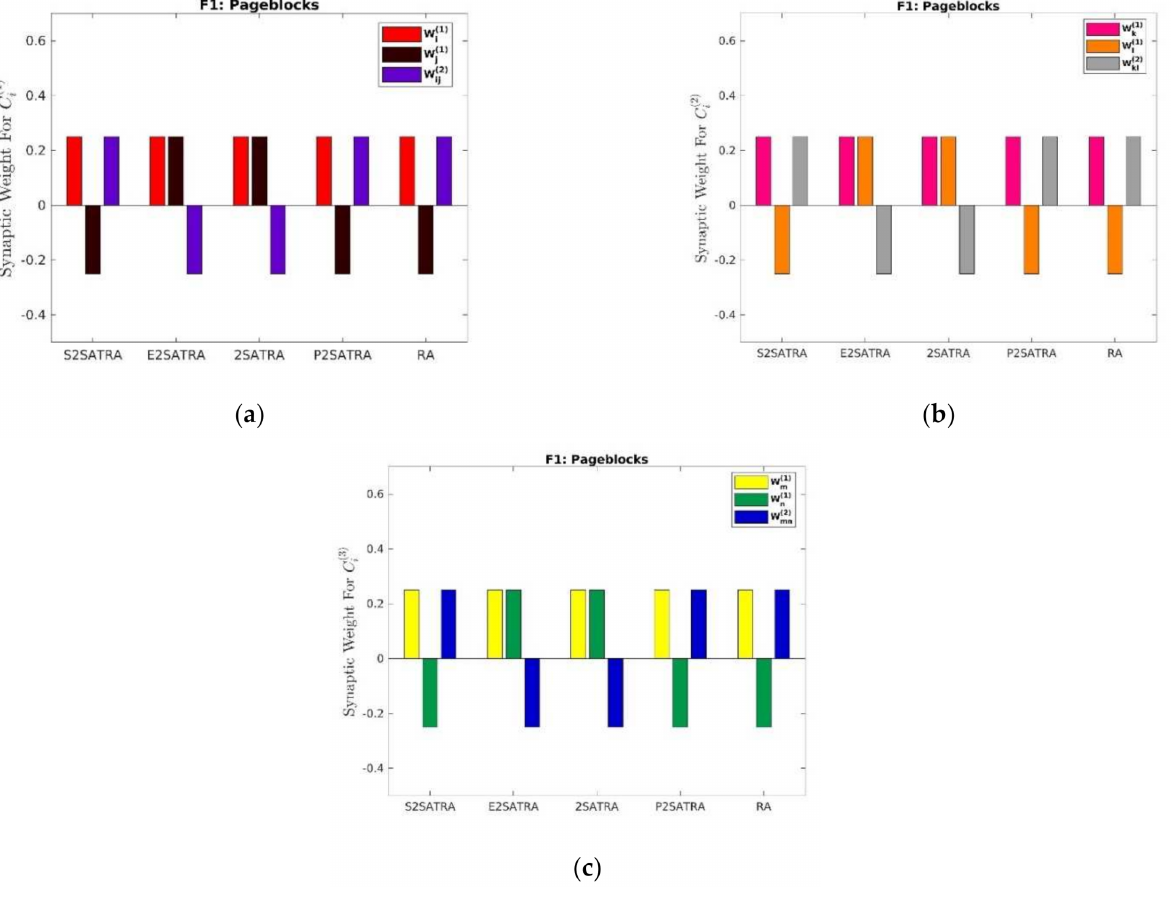
( 1 ) ( 2 ) ; ( b ) C and ( c ) C i i